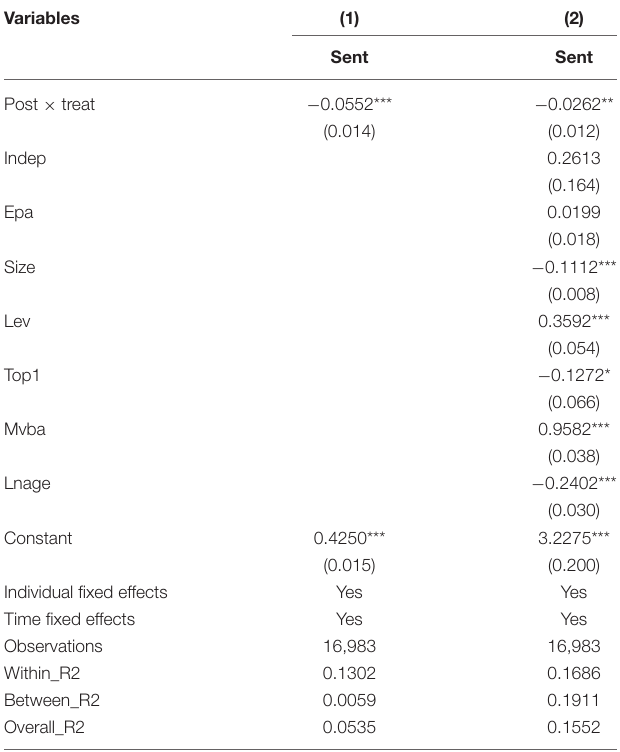
TABLE 4 | Benchmark model regression results.